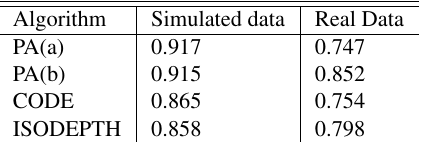
Table 2: Comparing PA performance (AUC) with baseline meth- ods. PA(a):with Mahalanobis distance, PA(b):learned distance metric.